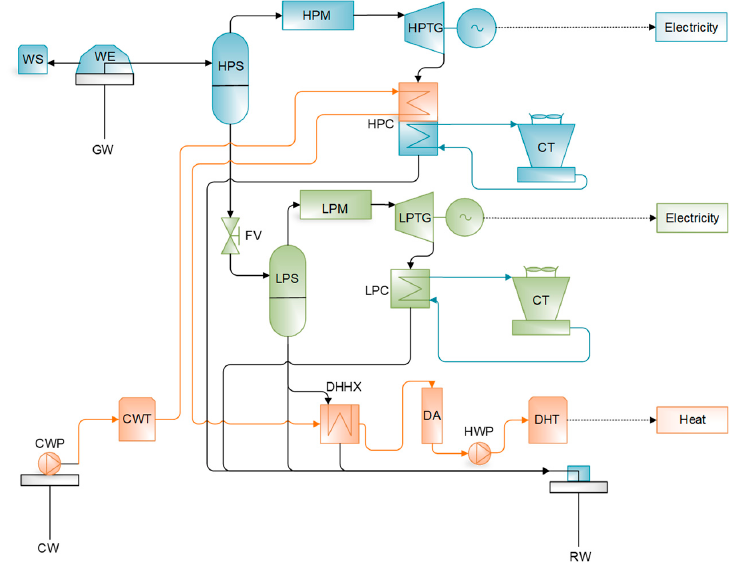
Figure 1. Schematic of the Hellisheidi geothermal CHP plant. WS: Well silencer; WE: Wellhead; GW: Geothermal well; HPS: High-pressure steam separator; HPM: High-pressure moisture remover; HPTG: High-pressure turbine-generator set; HPC: High-pressure condenser with preheater for district heat; CT: Cooling tower; FV: Flashing valve; LPS: Low-pressure steam separator; LPM: Low-pressure moisture remover; LPTG: Low-pressure turbine-generator set; LPC: Low-pressure condenser; CW: Coldwater well; CWP: Coldwater pump; CWT: Coldwater tank; DHHX: Heat exchanger for district heat; DA: Deaerator; HWP: Hot water pump; DHT: Hot water tank for district heat; RW: Reinjection